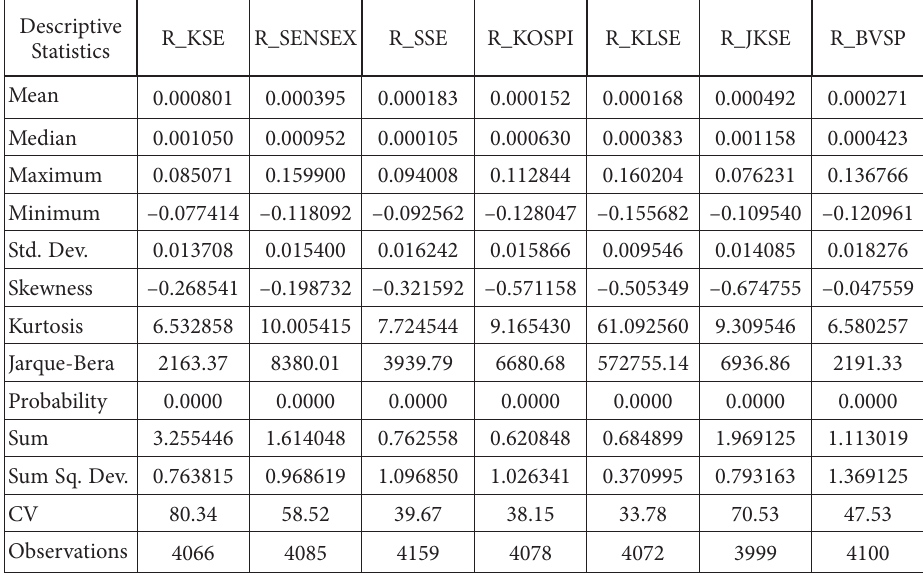
Table 1. Descriptive statistics for emerging stock